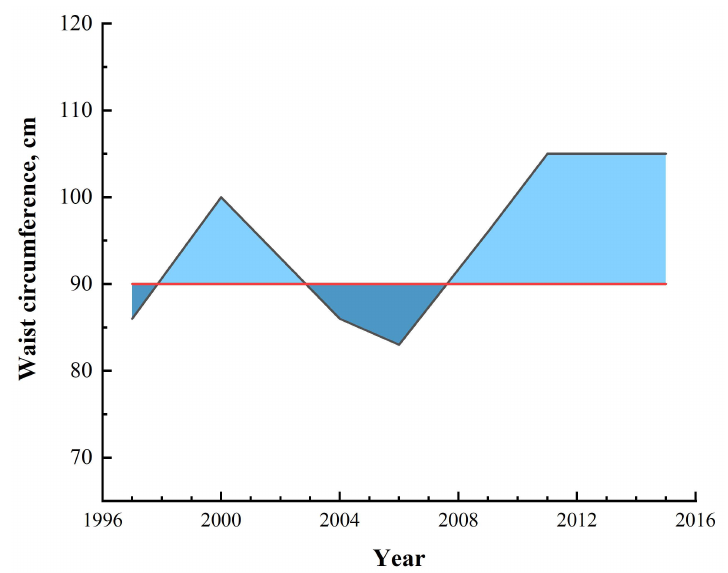
Figure 1. Illustration of waist circumference-year